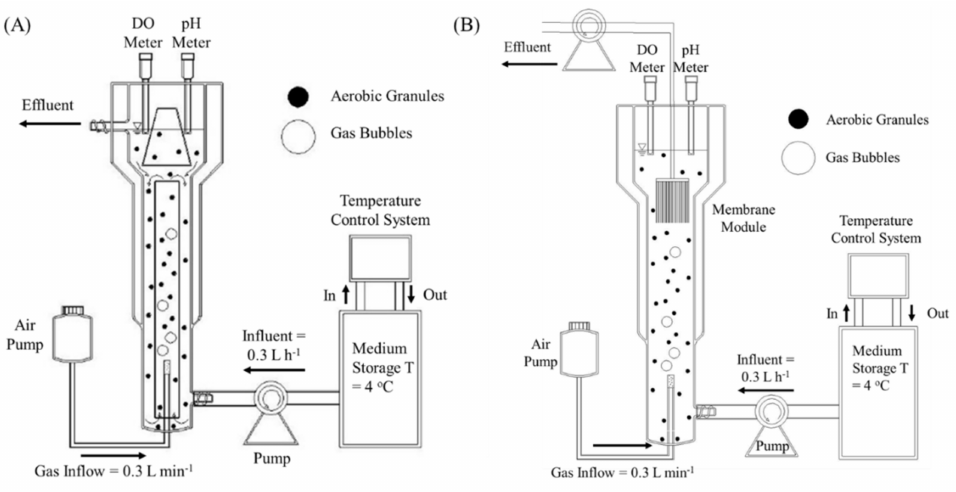
Figure 1. Reactor setup of the ALR ( A ) without membrane and the GMBR ( B ) with